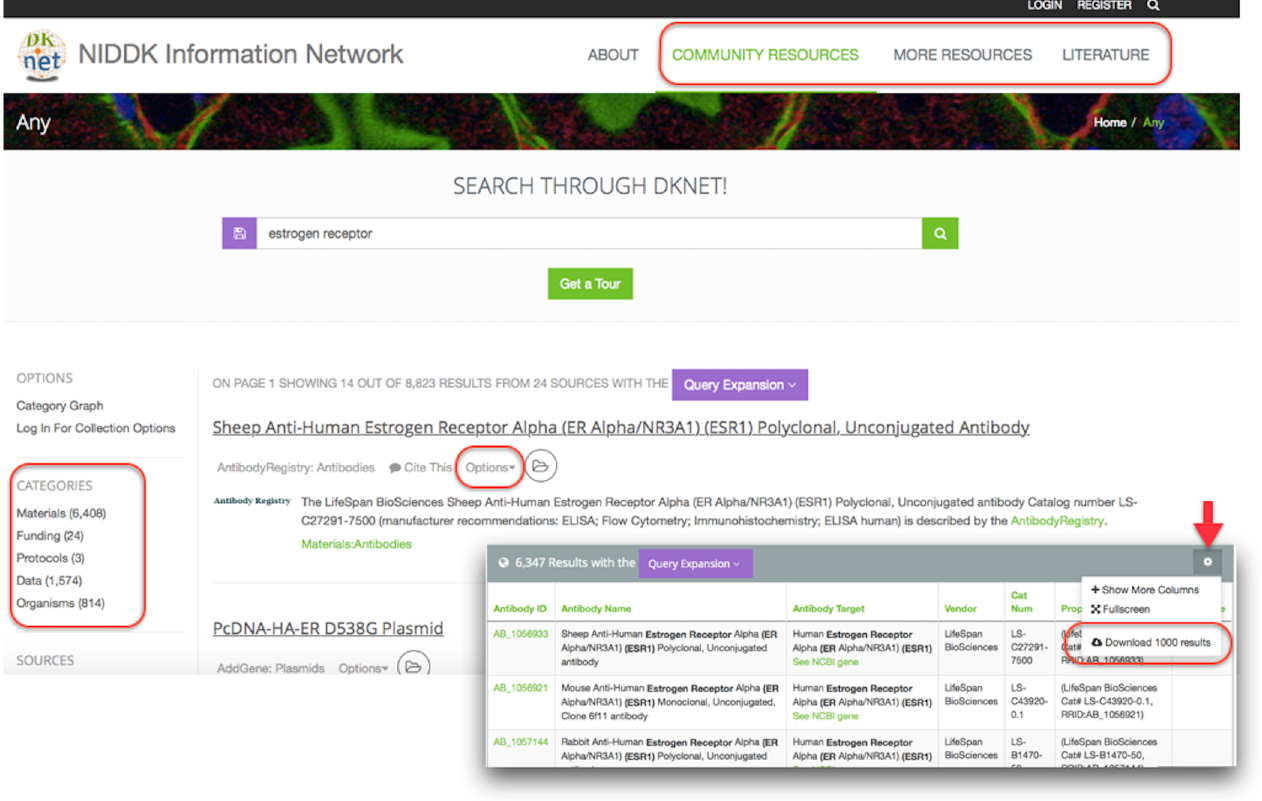
Fig 2. Main results page of dkNET search portal as of June, 2015. Search results are organized within 3 data views, indicated by the categories in the upper right menu (rectangle), and also via categories (rectangle, left side), subcategories and sources (left navigation menu). Results can be displayed as snippets (main window) or as a table (lower right) by selecting the Options menu next to each result. Results sets may be saved (see text) or exported as CSV files by selecting “ Download first 1000 results ” (oval) accessed via the tool icon in the upper right corner of the table view (red arrow).